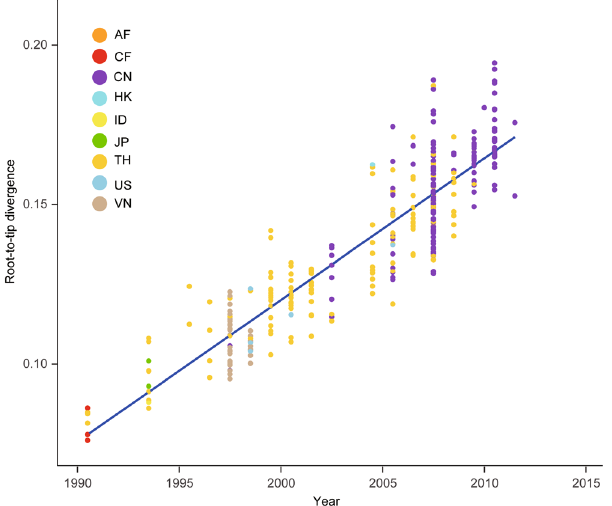
Figure 3. Regression of the root-to-tip genetic distance against year of sampling for 334 HIV-1 CRF01_AE sequences. Genetic distances are based on the tree in Supplementary Figure S2. Colors indicate different sampling locations.